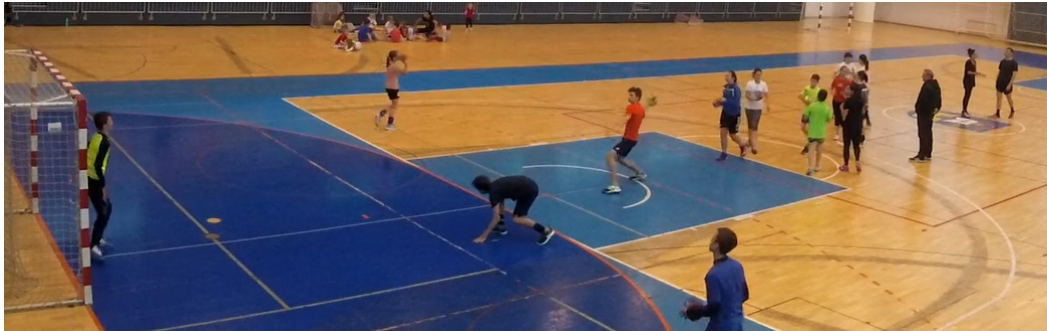
Figure 1. A typical training situation. The goalkeeper and the player in the center are performing the current task, while the rest are waiting, returning to queue, collecting the ball, etc.